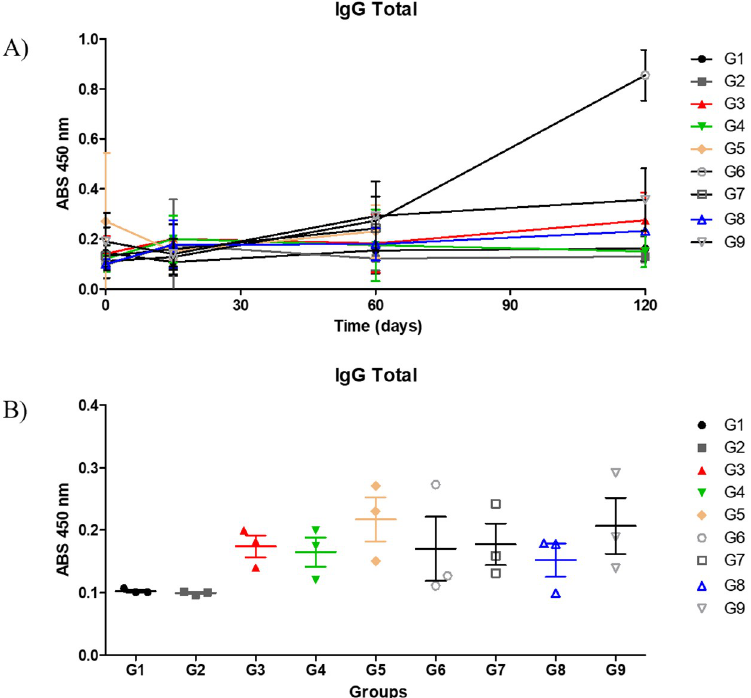
Fig 7. IgG Total antibody levels in mice immunized with different peptides. The results are presented as the mean and standard deviation (bars) of absorbance (nm) in the indirect ELISA assay for each experimental group with 12 animals. A) G1—inoculated with PBS; G2—inoculated with Saponin; G3—inoculated with Peptide 1 + saponin; G4— inoculated Peptide 2 + saponin and G5—inoculated with Peptide 3 + saponin; G6—inoculated with Peptide 4 + saponin; G7—inoculated with Peptide 5 + saponin; G8—inoculated with Peptide 6 + saponin and G9—inoculated with rCP40 + saponin. The blood was collected and evaluated on day 0 (pre-immune) and day 15 (before the second immunization) and 60 after the first immunization. Each ELISA was performed with rCP40. B) Immunogenicity of peptides and experimental groups on days 0, 15 and